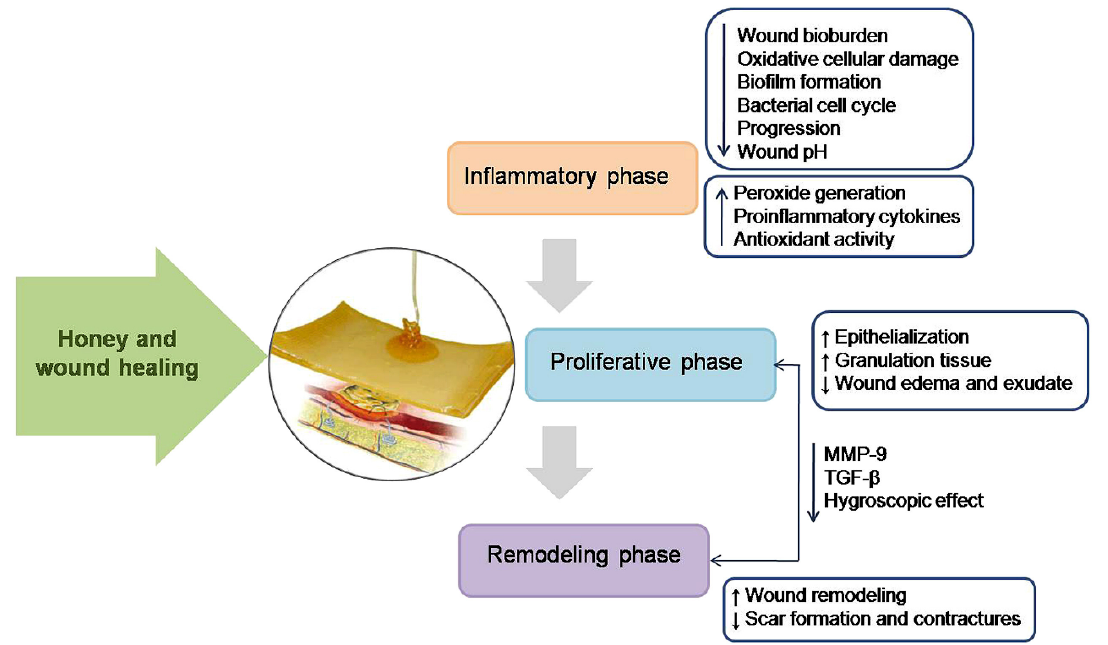
Figure 3. Modulatory impact of honey on the typical stages of wound healing. In the inflammatory phase, honey stimulates monocytes to release inflammatory cytokines, which play major roles in the initiation and amplification of inflammatory processes. It is able to remove debris and bacteria from the wound by stimulating neutrophils, macrophages, and phagocytosis during the inflammatory phase. The acidic nature of honey releases oxygen from the haemoglobin, a mechanism that stimulates granulation tissue formation and wound healing. It also promotes re-epithelialisation and holds the wound edges together due to its high osmotic pressure. Hydrogen peroxide contained at low levels in honey can stimulate the development of new capillaries and the growth and proliferation of fibroblasts and epithelial cells in wound tissue. Finally, in the remodelling phase, collagen is remodelled and realigned along tension lines, and cells that are no longer needed are removed by apoptosis. Reproduced from [30] with permission from Elsevier.